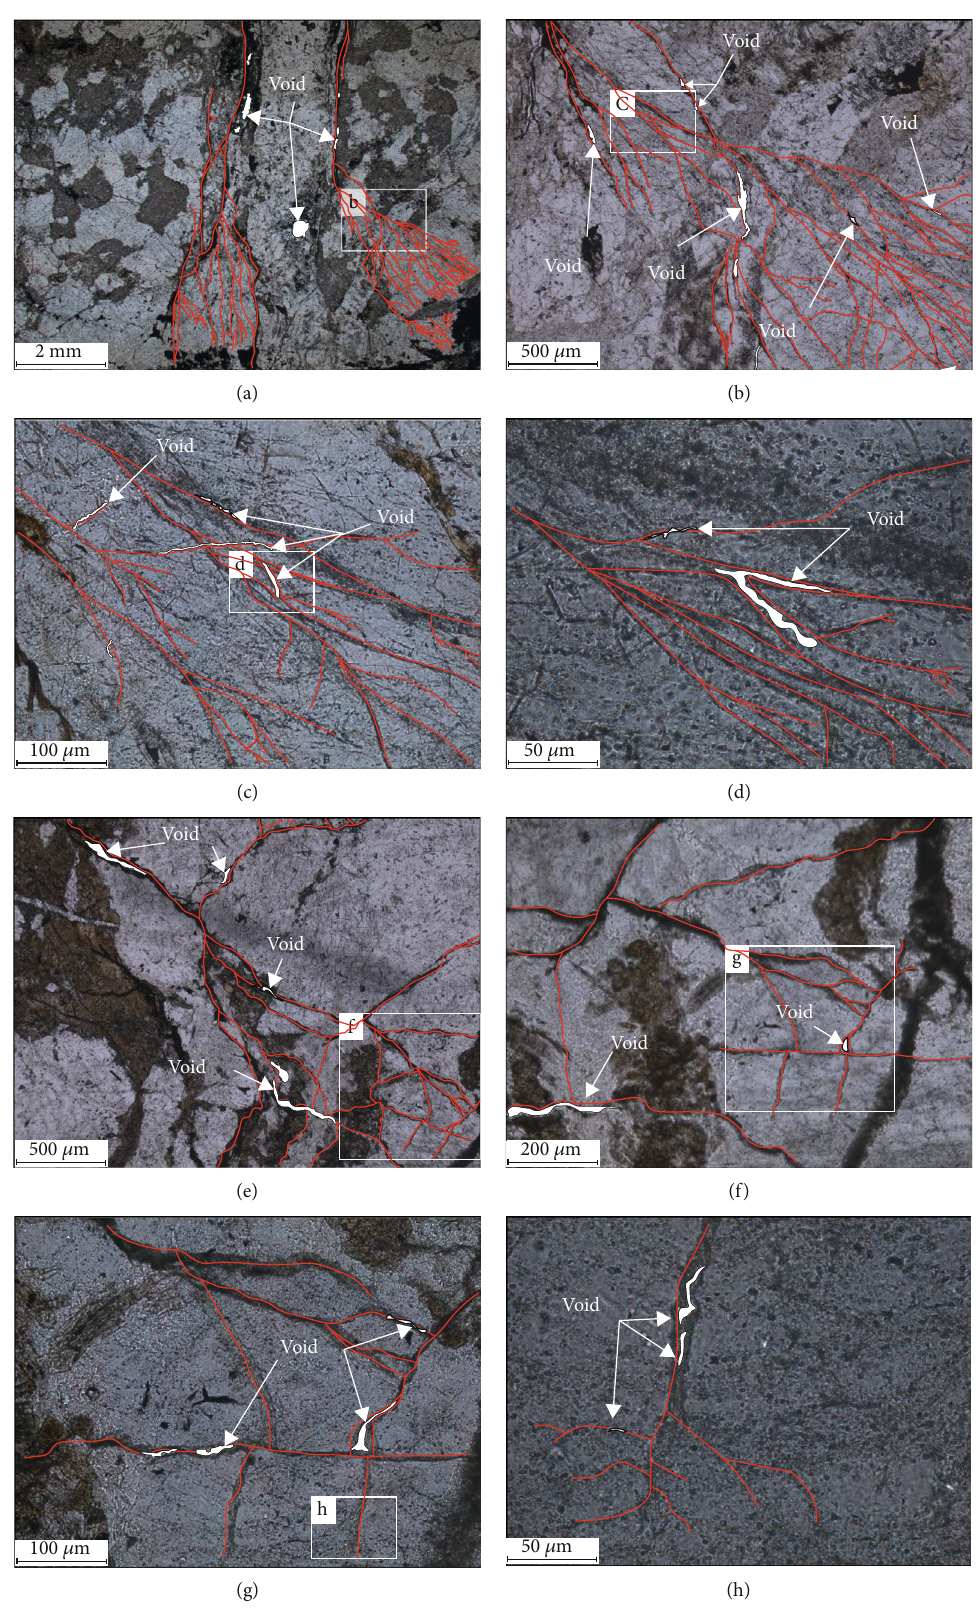
Figure 8: Fracture design for two samples ((a – d) and (e – h), respectively) and for smaller observation scales. Fractures underlined by red lines are marked by secondary mineral phases (mainly tourmaline and oxyde) and